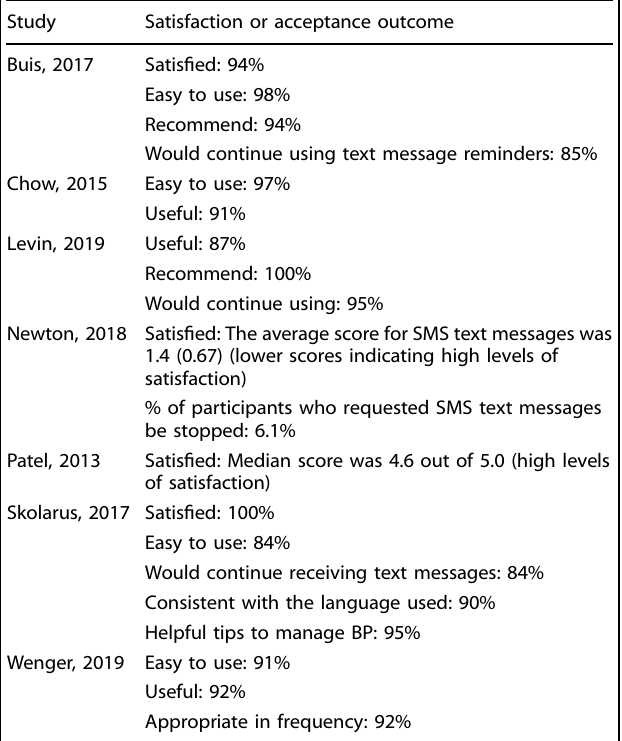
Table 6. Satisfaction and acceptance outcomes. Study Satisfaction or acceptance